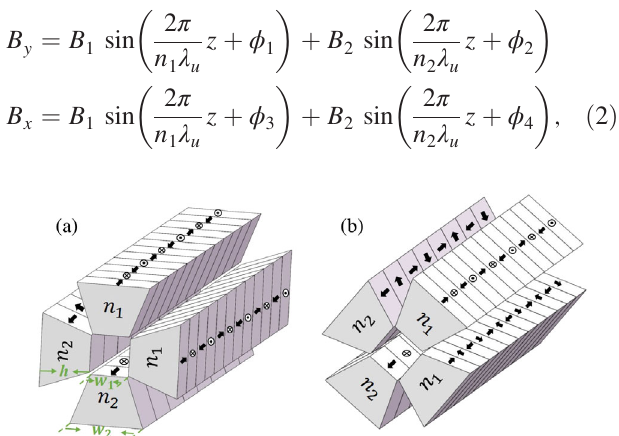
FIG. 3. Schematic illustrations of the proposed AMPU under DELTA-type (a) and APPLE-X-type (b) transverse structures with the period ratio n 1 ∶ n 2 at each direction.